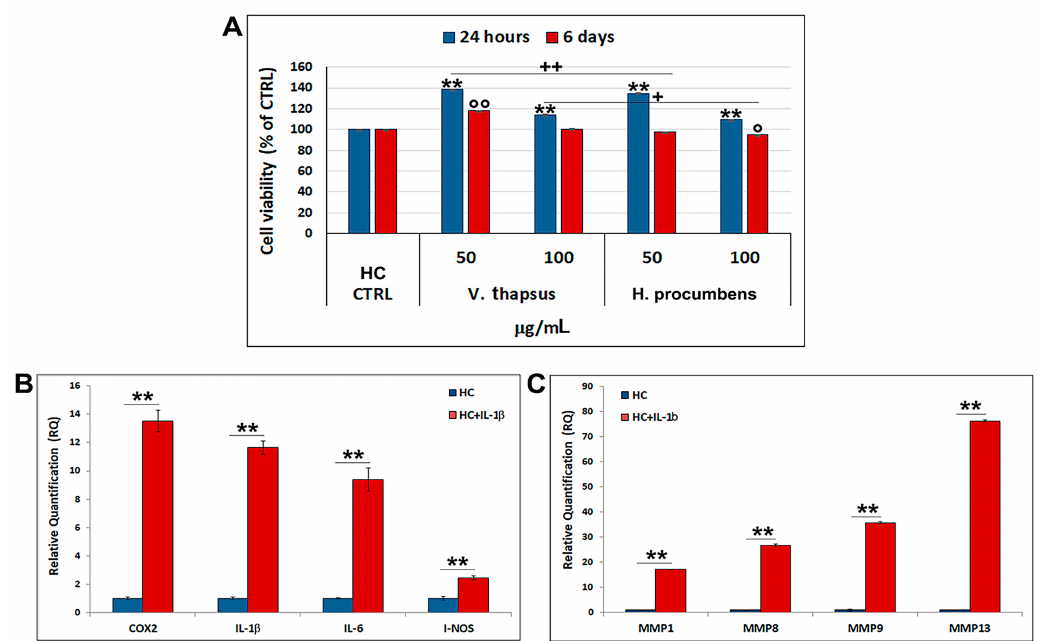
Figure 4. ( A ) Cell viability test performed on HC cells treated with V. thapsus and H. procumbens extracts (50 and 100 µ g/mL) for 24 h and 6 days. H. procumbens = positive control. ( B , C ) Gene expression profile of IL-1 β -stimulated HC with specifics inflammatory mediators and metalloproteases. Data are represented as the means ± SD of three independent experiments. ANOVA test p -values were reported ( p < 0.0001) and (**, ++ , ◦◦ p < 0.01 and + , ◦ p < 0.05) indicate significant differences between the two groups, as reported by the Holm post hoc test.